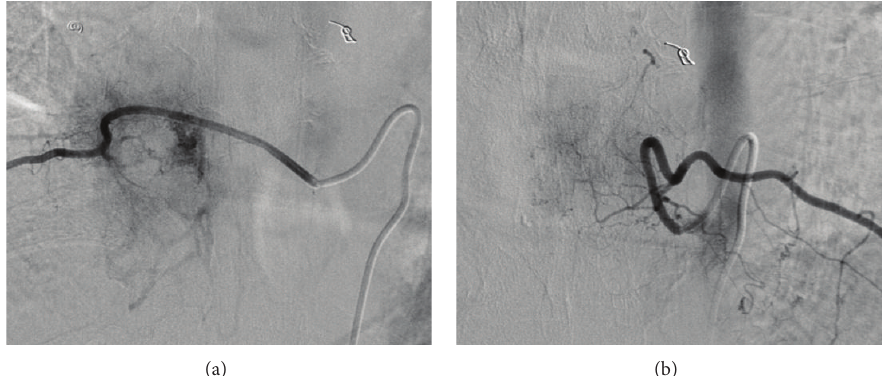
Figure 3: Preoperative spinal angiogram showing a tumor blush. T9 intercostal arteries: (a) right, (b) left.